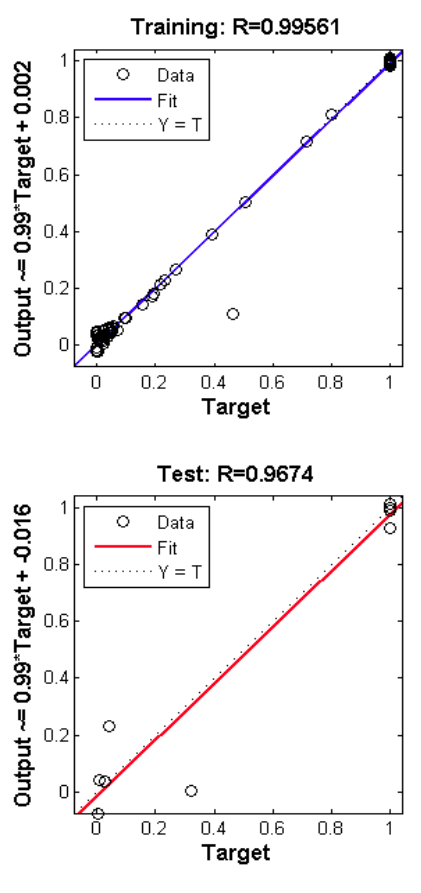
Figure 2. Regression analysis for the training and test data.